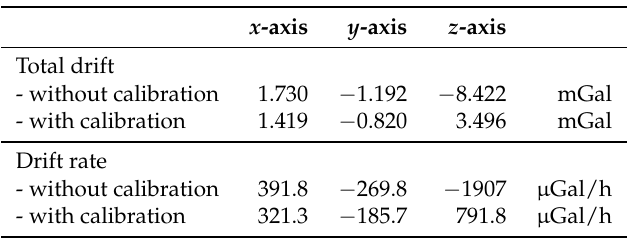
Table 1. Accelerometer drift over the entire flight.